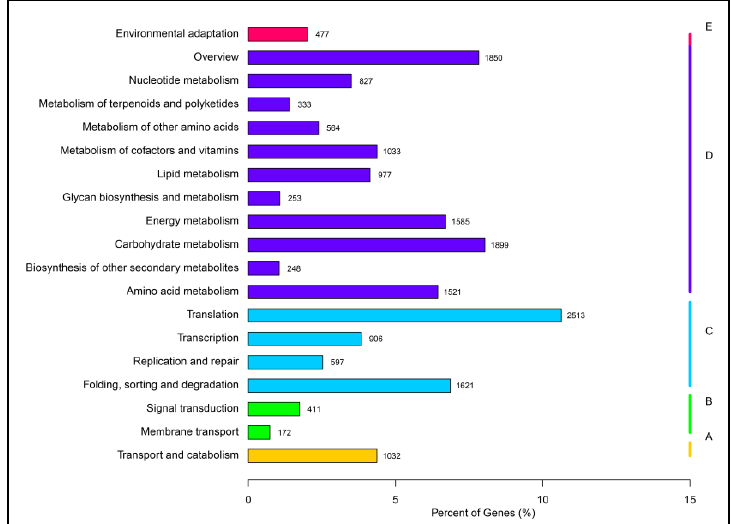
Figure 4. KEGG Classification. KEGG means Kyoto Encyclopedia of Genes and Genomes. The Y axis gives specific pathways in the second hierarchy. “A, B, C, D and E” (yellow, green, blue, purple and pink) represent five groups of pathways in the first hierarchy: Cellular Processes, Environmental Information Processing, Genetic Information Processing and Organismal Systems.